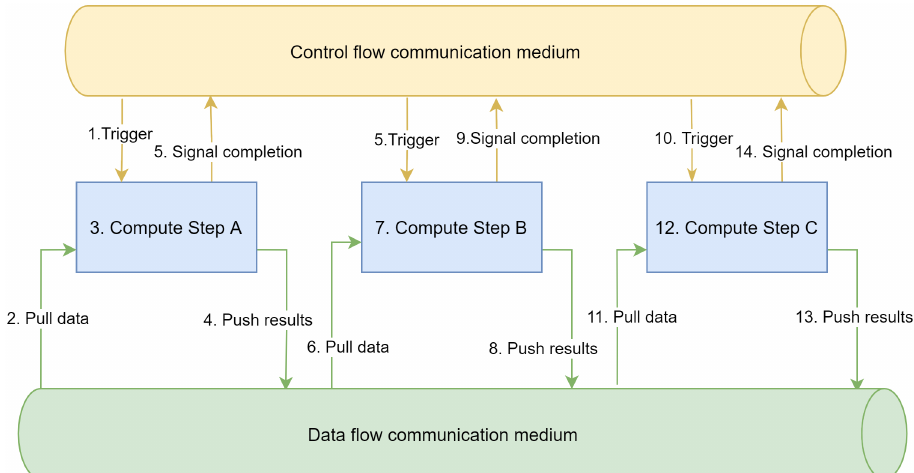
Figure 1. Workflow as sequence of steps with communication